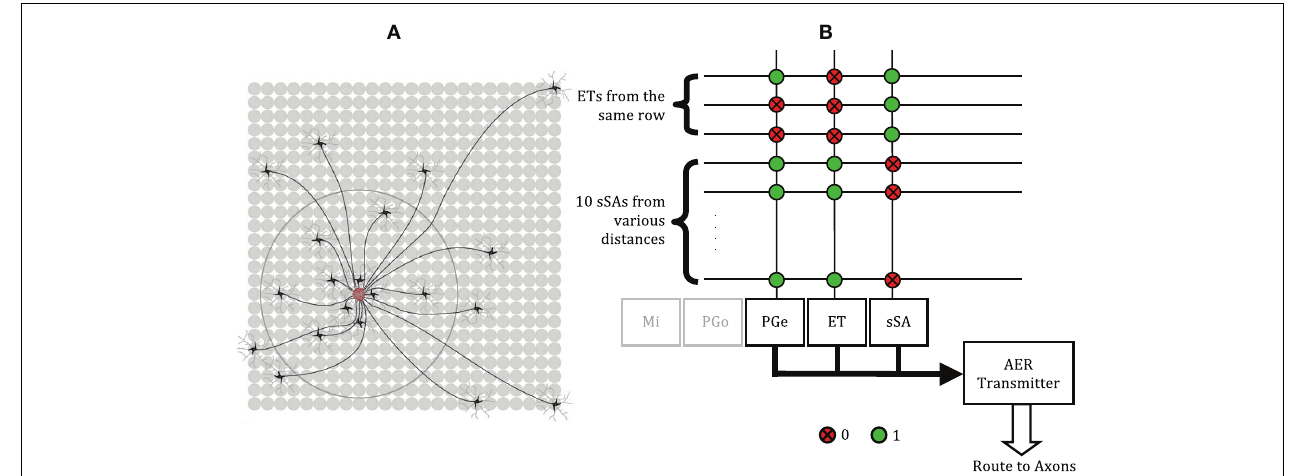
normalization effects of the ET/sSA lateral network. Each sSA neuron receives input from ET cells from the same row.The PGe and ET neurons of each of the 48 columns receive input from 10 sSA neurons, most of which are located in neighboring rows, but some of which are more than five rows away. Spikes generated by an sSA neuron are routed to its axon in the crossbar which synapses with the PGe and ET cells of 10 different glomeruli.The outputs of the PGe and ET neurons also are routed to their axons in order to make the appropriate inter- and intra-glomerular connections (see Figure 1 ).